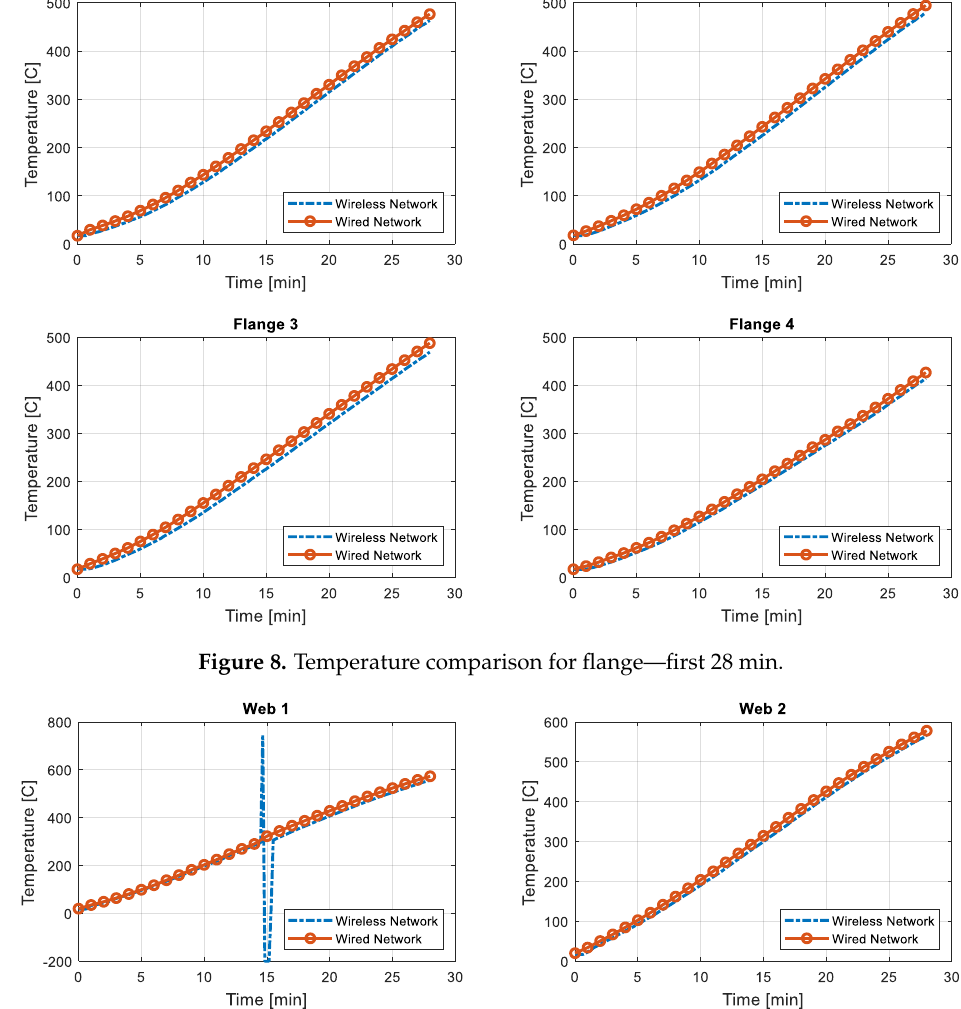
Figure 9. Temperature comparison for web—first 28 min.